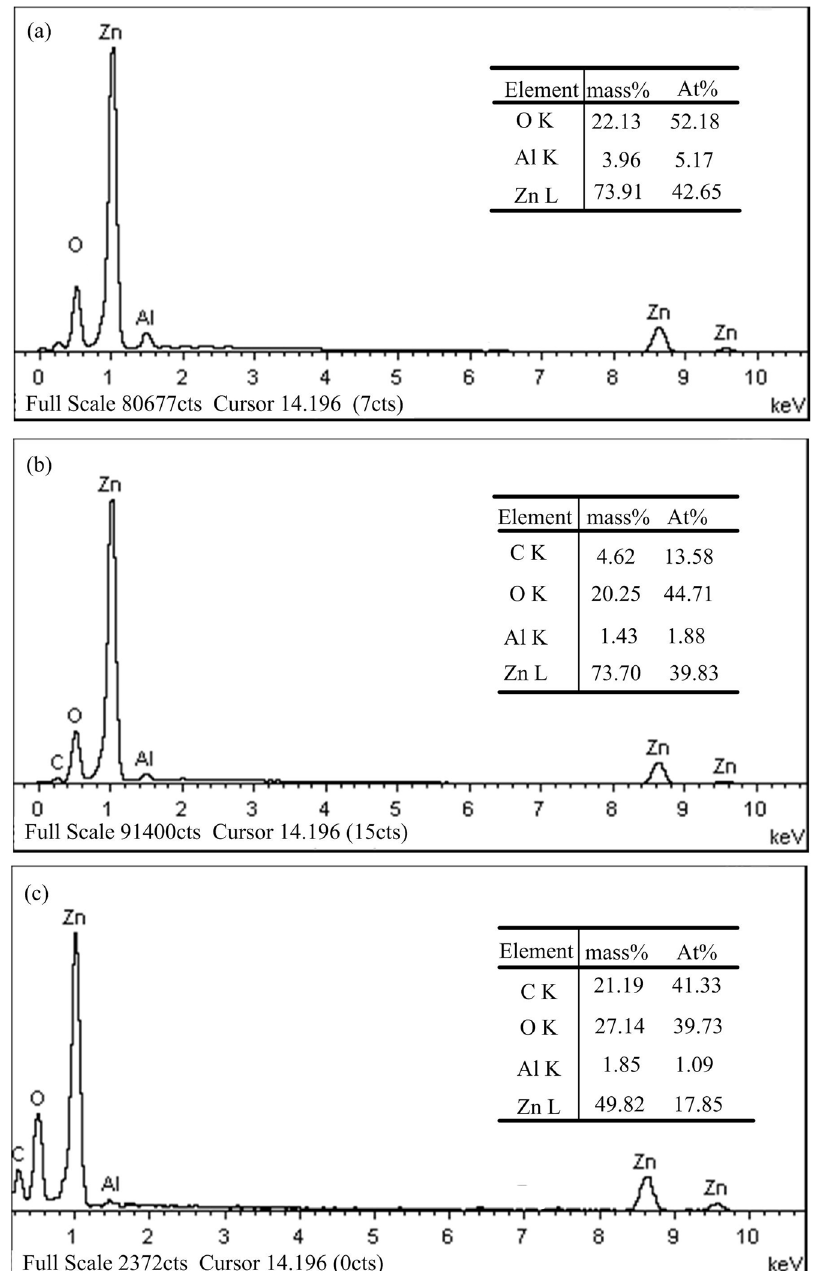
Figure 17. EDS analysis of ZnO/Al 2 O 3 surfaces with different electrode materials: (a) unprocessed; (b) copper; (c) graphite.